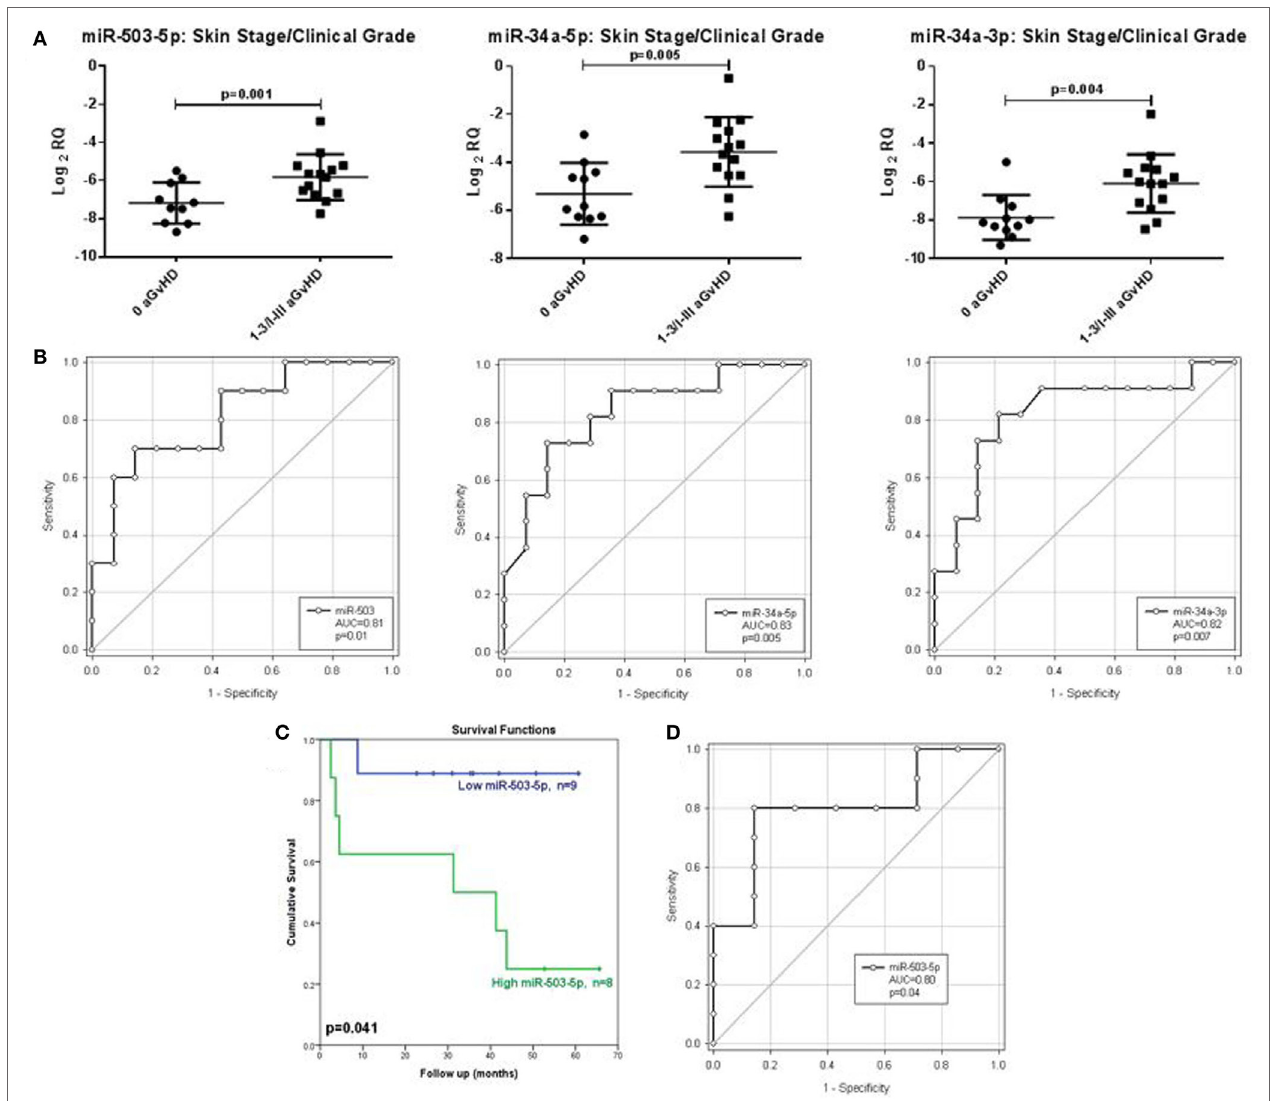
FigUre 5 | Association between serum expression of miR-503-5p, miR-34a-5p and miR-34a-3p with skin histopathological aGvHD incidence, overall clinical aGvHD grade and overall survival. (a) Scatterplots demonstrating miR-503-5p, miR-34a-5p, and miR-34a-3p expression (mean and SEM) in serum samples at Day 28 post-HSCT according to skin aGvHD stage/overall aGvHD grade. Significance was determined using the Student’s t -test. (b) Receiver operator characteristic (ROC) curves detailing area under the curve (AUC) and p -value significance for miR-503-5p, miR-34a-5p, and miR-34a-3p with incidence of skin aGvHD/clinical aGvHD. (c) Kaplan–Meier survival curves for OS, based on dichotomized miR-503-5p expression. p -Values were calculated using the Log-Rank test. (D) ROC curve detailing AUC and p -value significance for miR-503-5p and